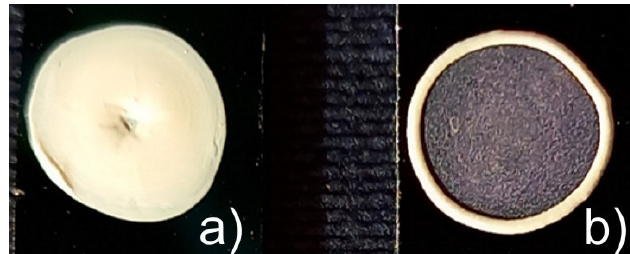
Figure 1. Digital photos of drops of aqueous suspensions of ( a ) spheroidal particles (P(S/PGL) s 3 and ( b ) microspheres P(S/PGL) m after deposition on silicon supports and drying at room temper- ature.